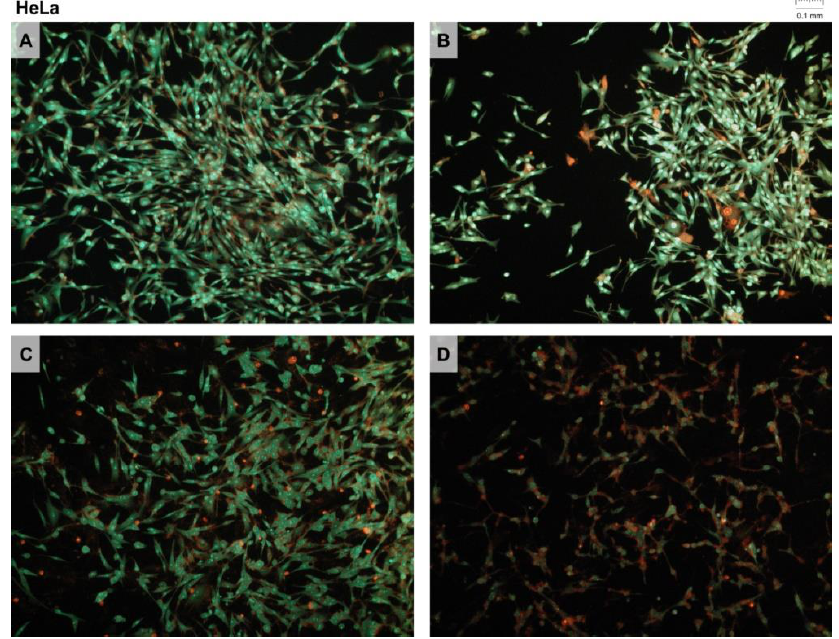
Figure 4. Double fluorescent staining of HeLa cell samples after 24 h treatment with extracts (DE, SWE) and resveratrol (RSV): control ( A ), dry extract ( B ), subcritical water extract ( C ) and resveratrol ( D ). Stained cells were photographed with an Olympus Camedia 3040 digital camera mounted on an Olympus BX51 microscope with a 10× magnification lens. Different intensities of fluorescent signals of the two colors can be observed.